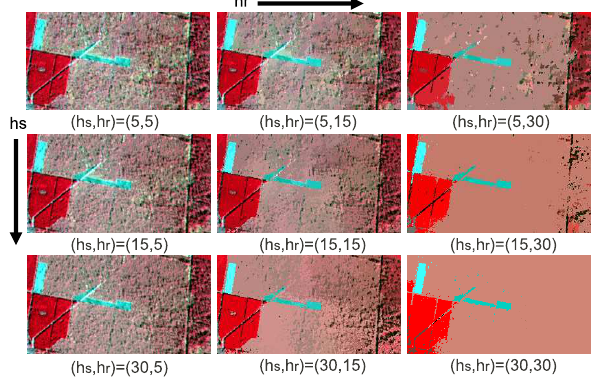
Figure 1: Mean shift segmentations of a 4-channel image (B,G,R,NIR) using different parameters ( h s , h r ). When h r in- creases, only highly contrasted and homogeneous regions remain: intact young stand on the left, blue farming area, medium aged stand on the right. If h s increases, only larger regions remain : shadow areas and standing tree groups disappear within the cen- tral, strongly damaged area.